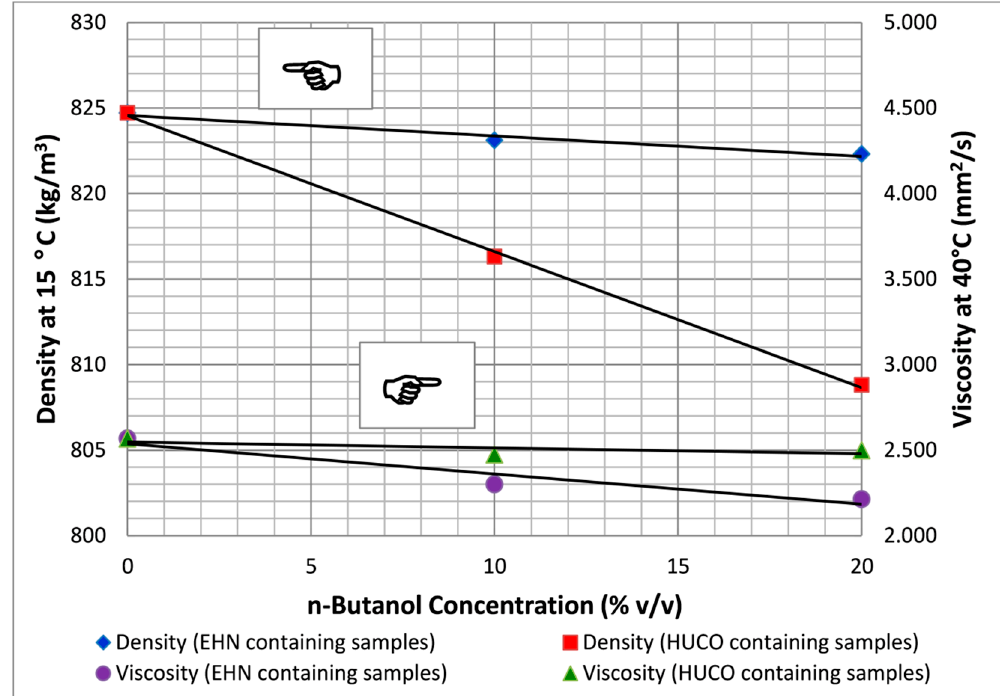
Figure 5. Density and viscosity of the studied fuels with the same DCN (Bu10E, Bu10H, Bu20E, and Bu20H, where the number refers to the percentage ( v / v ) n -butanol, E refers to EHN, and H refers to HUCO.